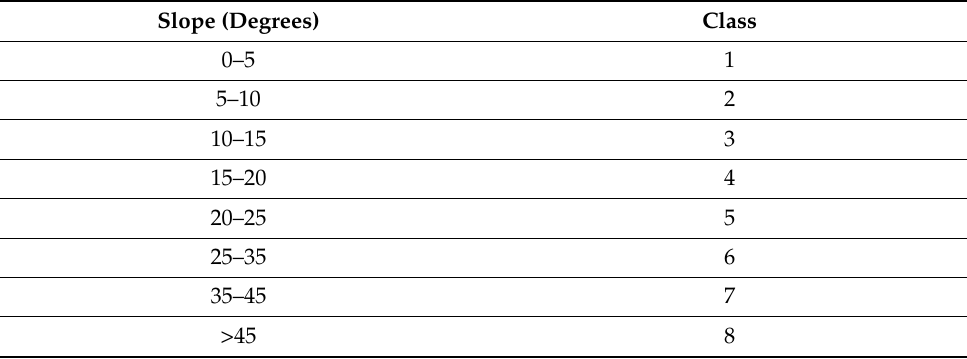
Table 2. Classes of slope for the training data